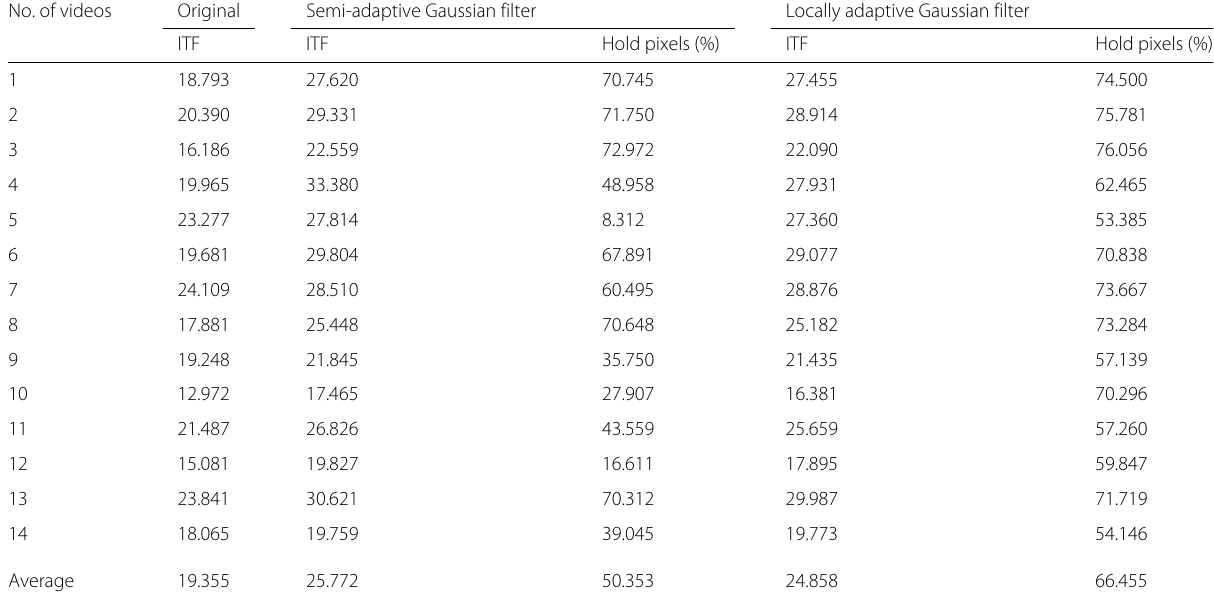
Table 3 Comparison between semi-adaptive Gaussian filter and adaptive Gaussian filter No. of videos